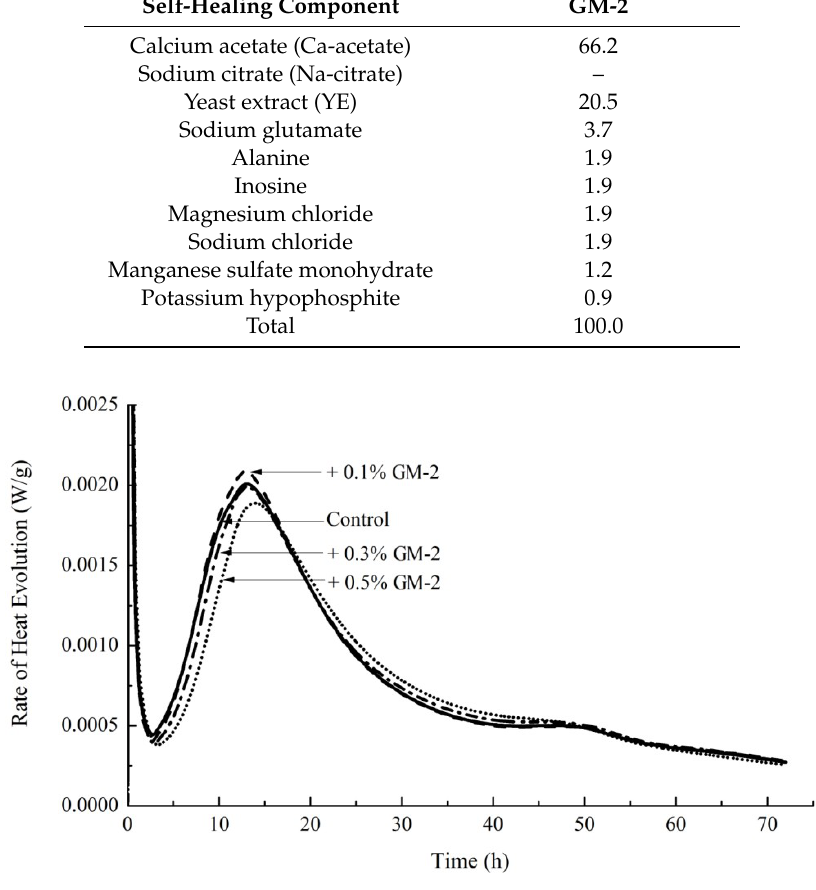
Figure 9 . Hydration kinetics of cement paste containing GM-2 at proportions of 0.1%, 0.3%, and 0.5% of the mass of cement.